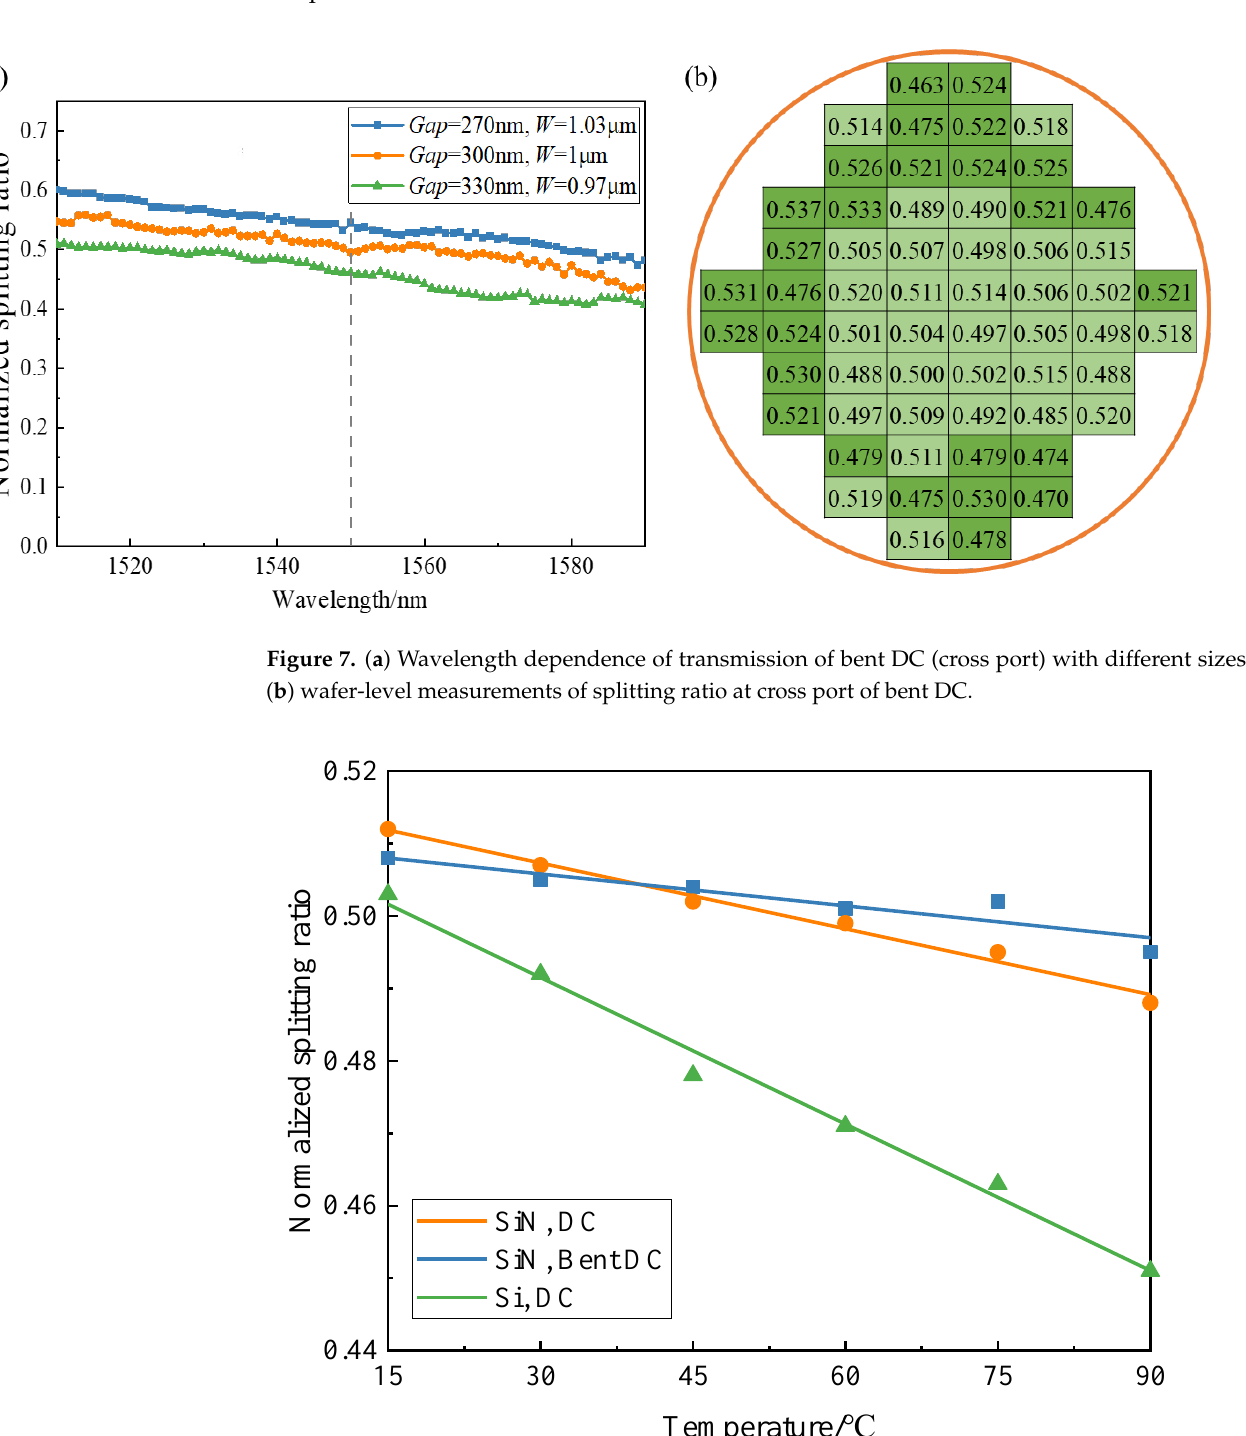
Figure 8. Temperature dependence of splitting ratio (cross port) of the silicon-based conventional DC, silicon nitride conventional DC, and silicon nitride bent DC at the wavelength of 1550 nm.